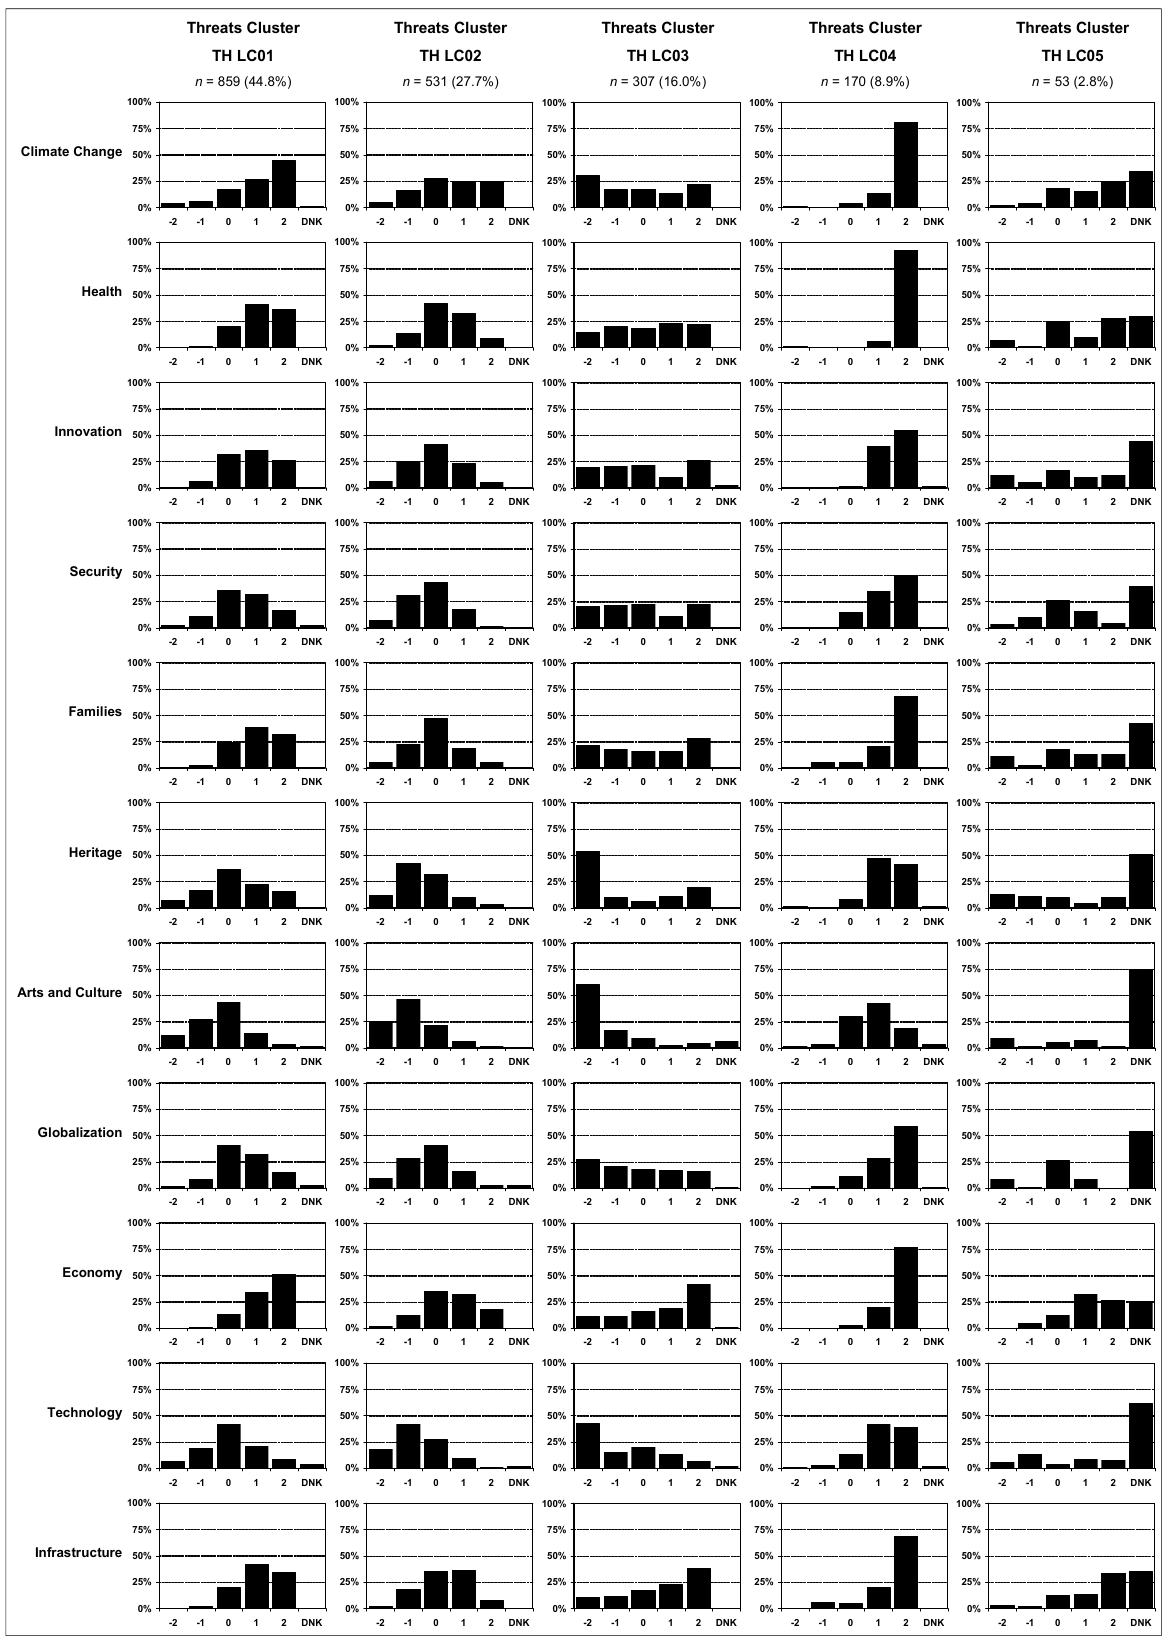
Figure 4. Threat-based cluster summary. X-axis scale: − 2 = not at all important, to +2 = very important; DNK = do not